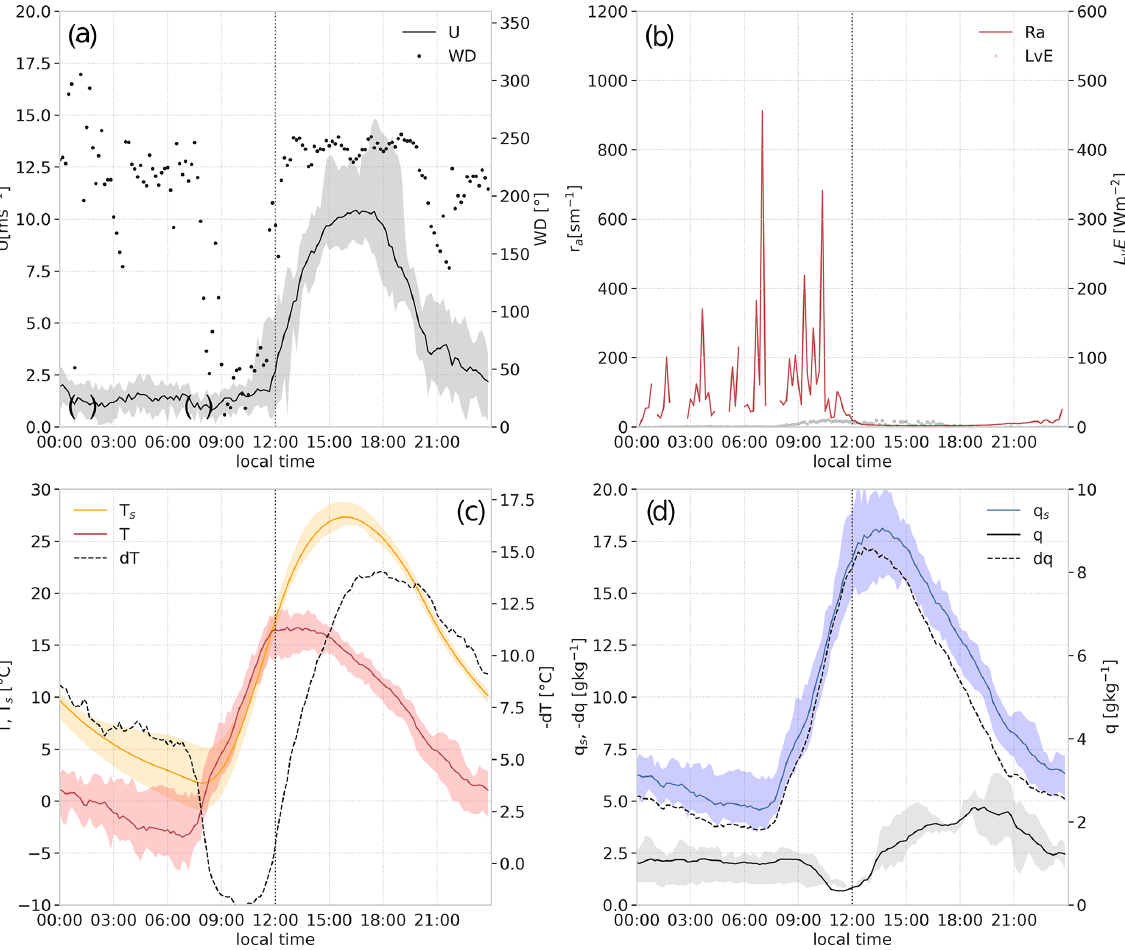
Figure B1. (a) Mean diurnal cycle of wind speed ( U ) and wind direction (WD) of a representative day (18 November); (b) mean diurnal cycle of aerodynamic resistance ( r a ); (c) air temperature ( T ), surface temperature ( T s ) and thermal gradient ( − d T ); and (d) air specific humidity ( q ), surface saturated specific humidity ( q s ) and moisture gradient ( − d q ) observed over the desert surface. Vertical dotted lines indicate time of turbulent regime change, and shadings represent maximum and minimum observations. Observations from 15–24 November 2018.